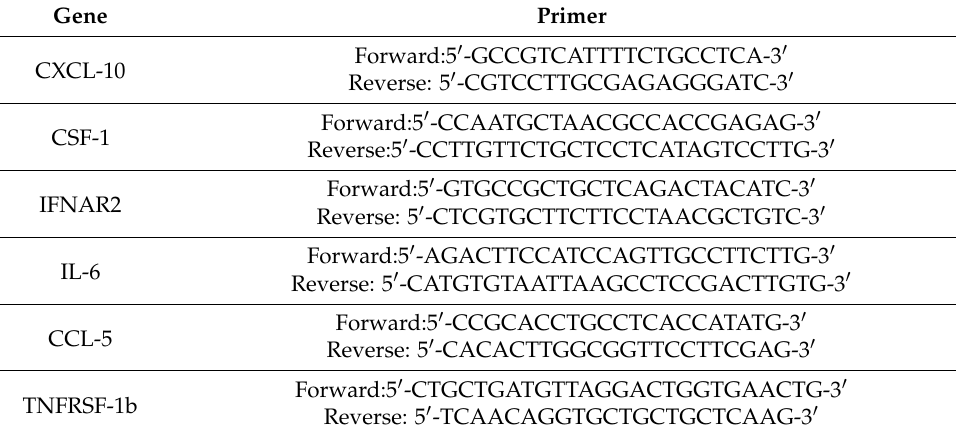
Table 1. Primer sequences and reaction parameters used for qRT-PCR